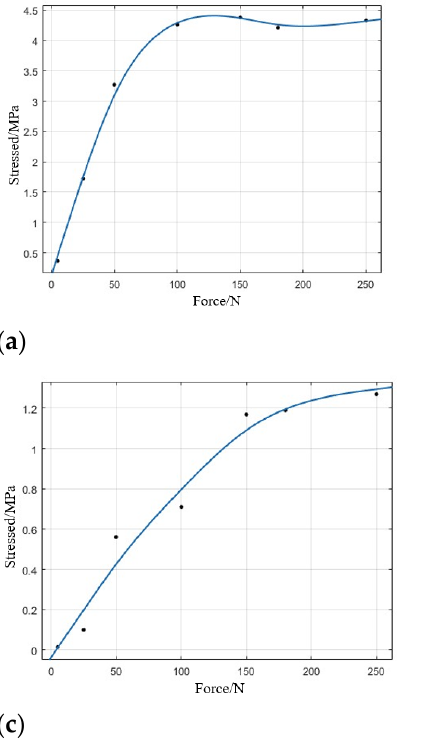
Figure 7. Maximum stress fitting curve of the kiwifruit. ( a ) peel; ( b ) flesh; ( c ) placenta. Note: The dark dots represent the stress values of different forces .